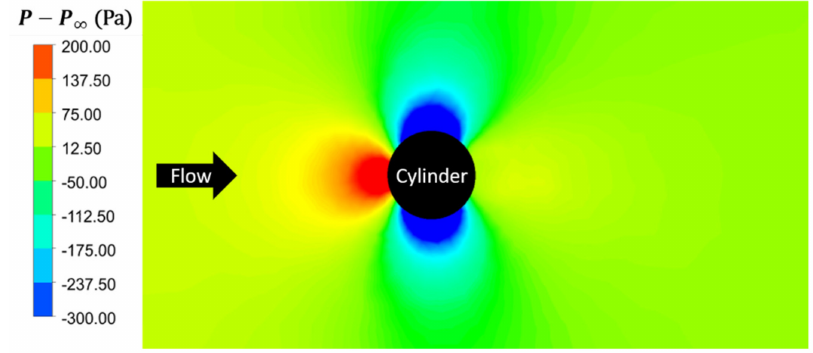
Figure 8. Effects of obstruction (no TLC) on the pressure field (top view).